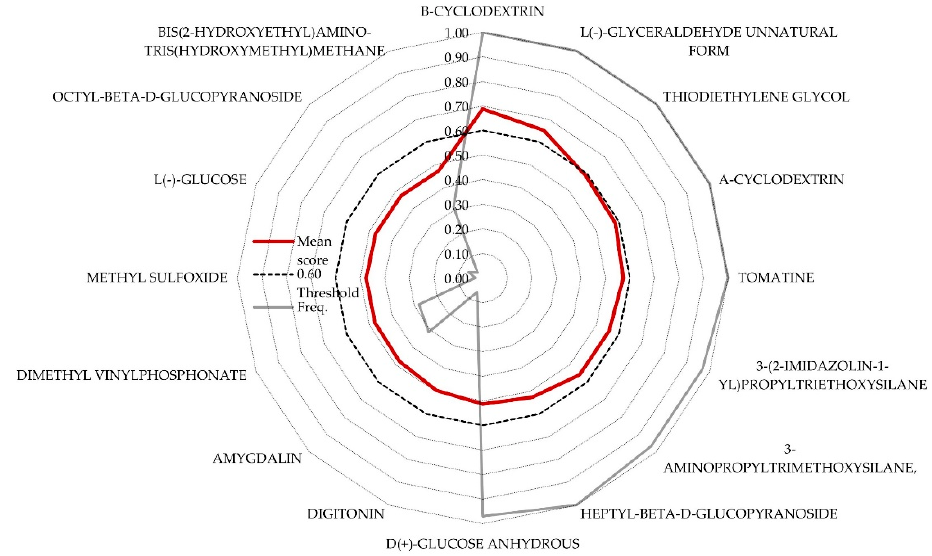
Figure 1. Radar plot with mean scores of the top 16 detected compounds in all samples, along with the 0.60 score threshold and frequency of appearance in top 10 hits from the compound database.